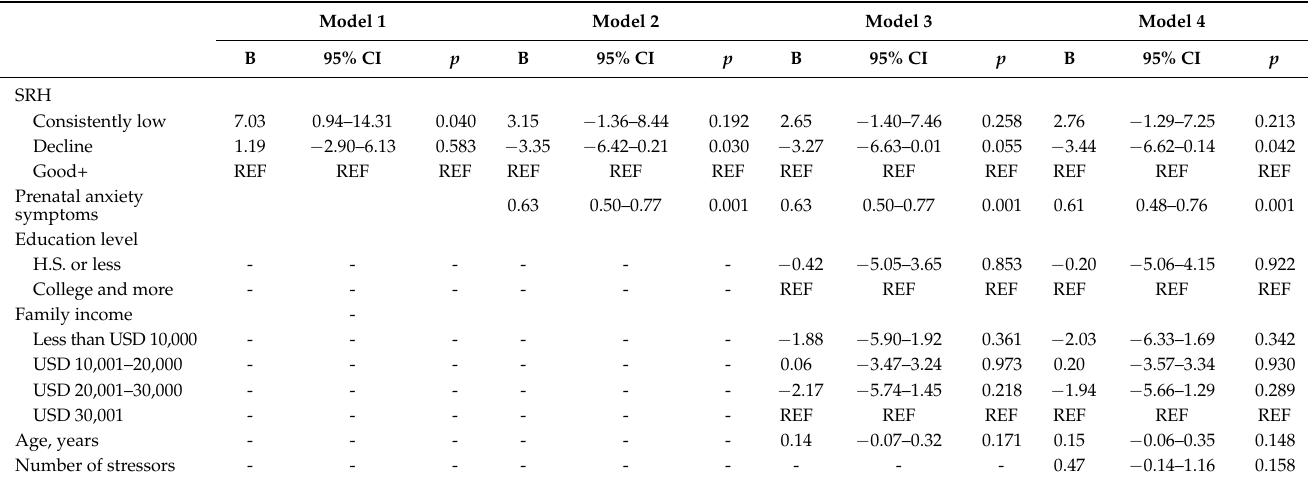
Table 6. Crude and Multiple Adjusted Linear Regression Models Examining Associations between Change in Self-Rated Health and Postpartum Anxiety Symptoms at Six